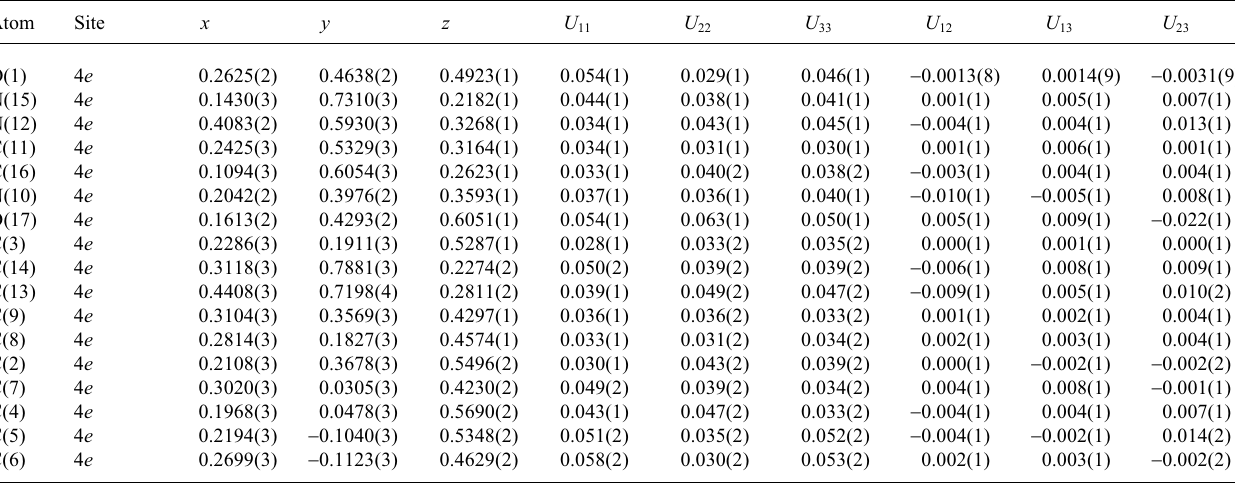
Table 3. Atomic coordinates and displacement parameters (in Å 2 )